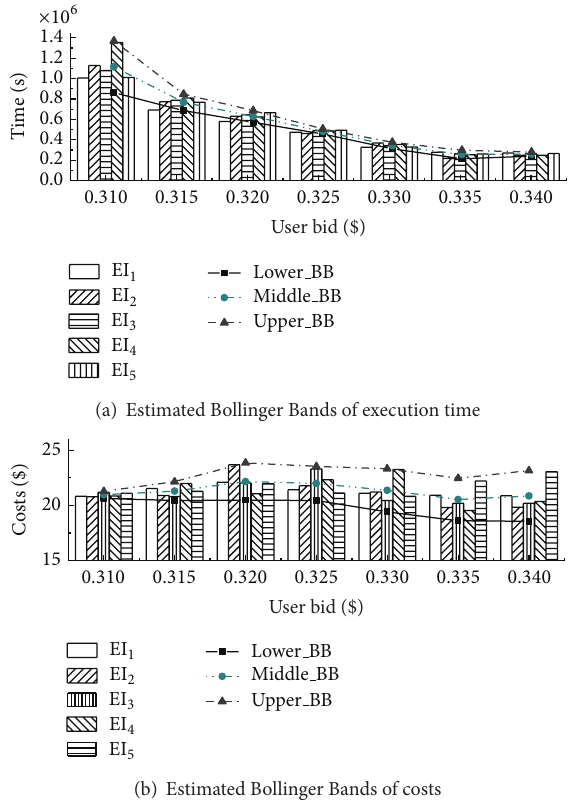
Figure 12: Estimated execution time, cost, and Bollinger Bands of each EI zone computed with the past price